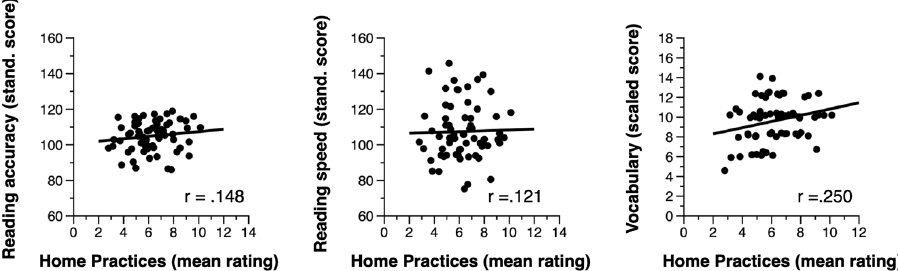
Fig. 3 Behavioral results. Scatterplots of child reading accuracy, reading speed, and vocabulary as a function of the overall frequency of home literacy practices (controlled for parental income and education, n = 66).